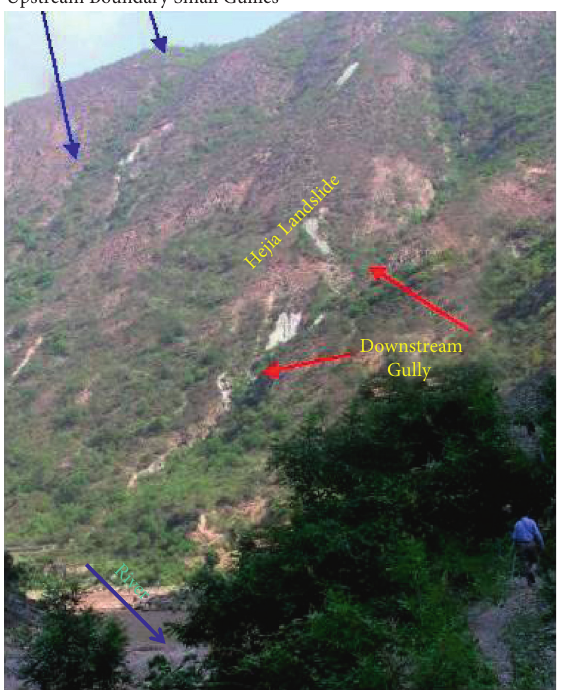
Figure 8: Downstream gully and downstream boundary of the Hejia landslide. Table 1: Physical indicators of the sliding zone soil.